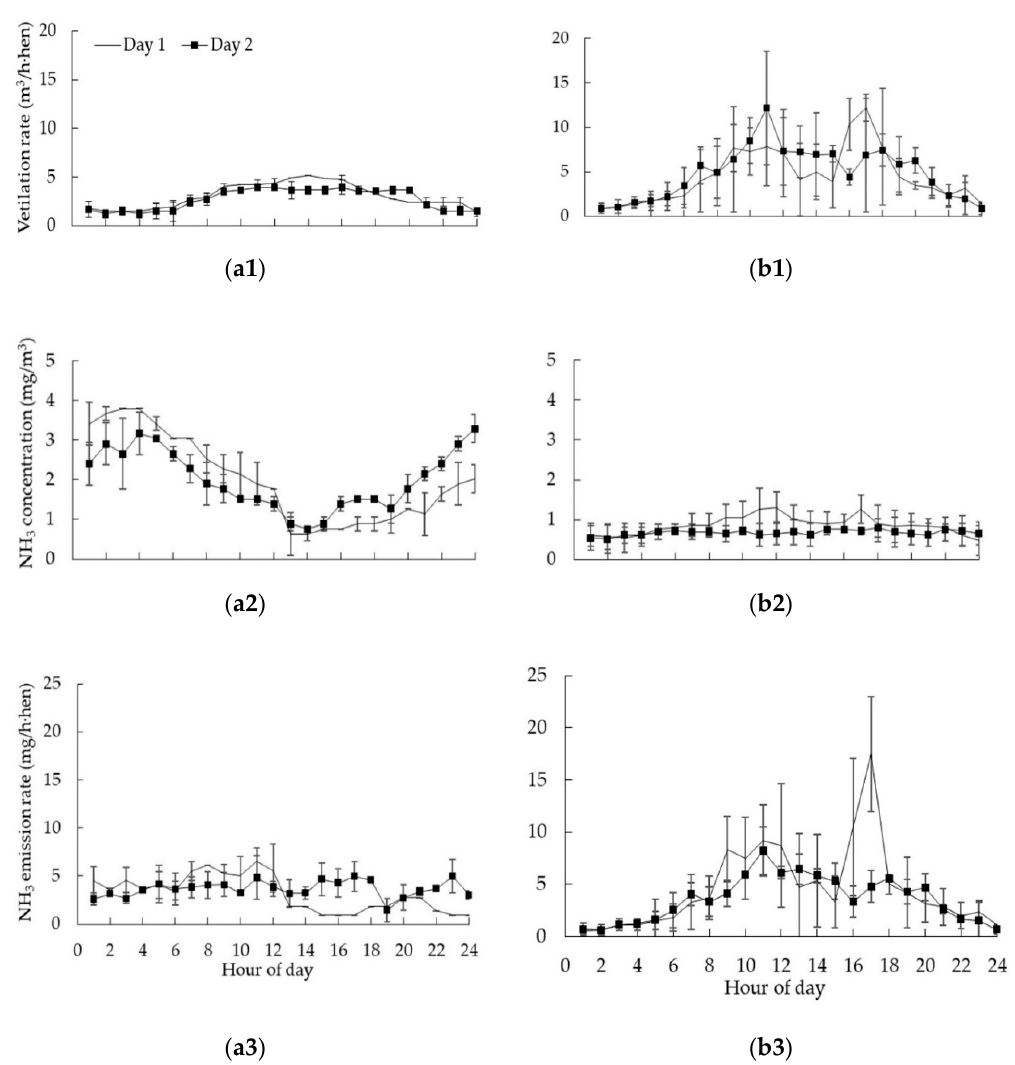
Figure 3. Diurnal patterns average VR, NH 3 concentration, and emissions in CC ( a ) and AV ( b ). (Day 1 means the day with manure removal; Day 2 means the day after manure removal. Error bar was plotted by using standard deviation.)